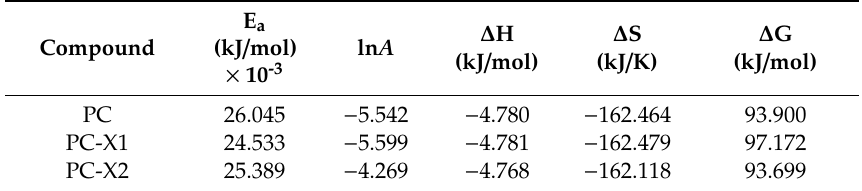
Figure 7. Plots of –Ln(ln(-1 / y)) vs 1 / T × 10 -3 ( a ) for the decomposition step of PC, PC-X1 and PC-X2 in the range 250–360 °C; ( b ) for the first decomposition step of SNC-PC-X1 and SNC-PC-X2 in the range 200–270 °C; and ( c ) for the second decomposition step of SNC-PC-X1 and SNC-PC-X2 in the range 270–340 °C. Table 1. Kinetic and thermodynamic parameters of PC, PC-X1 and PC-X2 at the decomposition range of 250–360 °C.